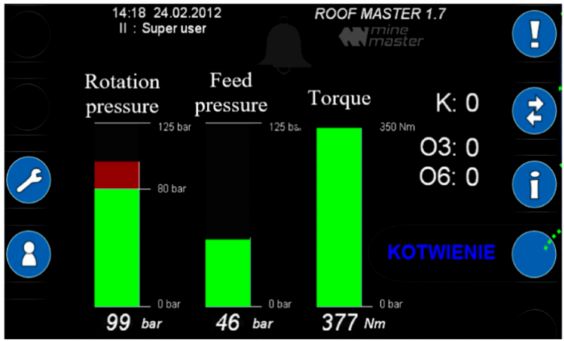
Figure 5. The main panel of the Roof Master 1.4.